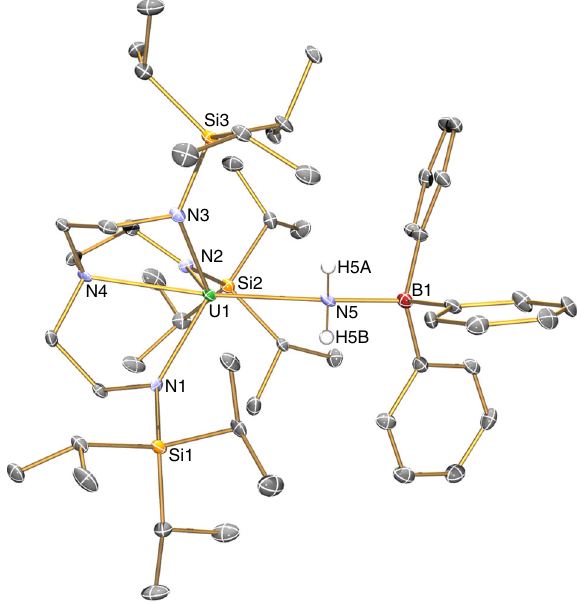
Fig. 7 Molecular structure of 8 at 150K and displacement ellipsoids set to 40%. Nonamide hydrogen atoms and lattice solvent are omitted for clarity. Selected bond lengths (Å): U1-N1, 2.236(5); U1-N2, 2.221(5); U1-N3, 2.246(4); U1-N4, 2.645(5); U1-N5, 2.578(5); B1-N5, 1.637(9).